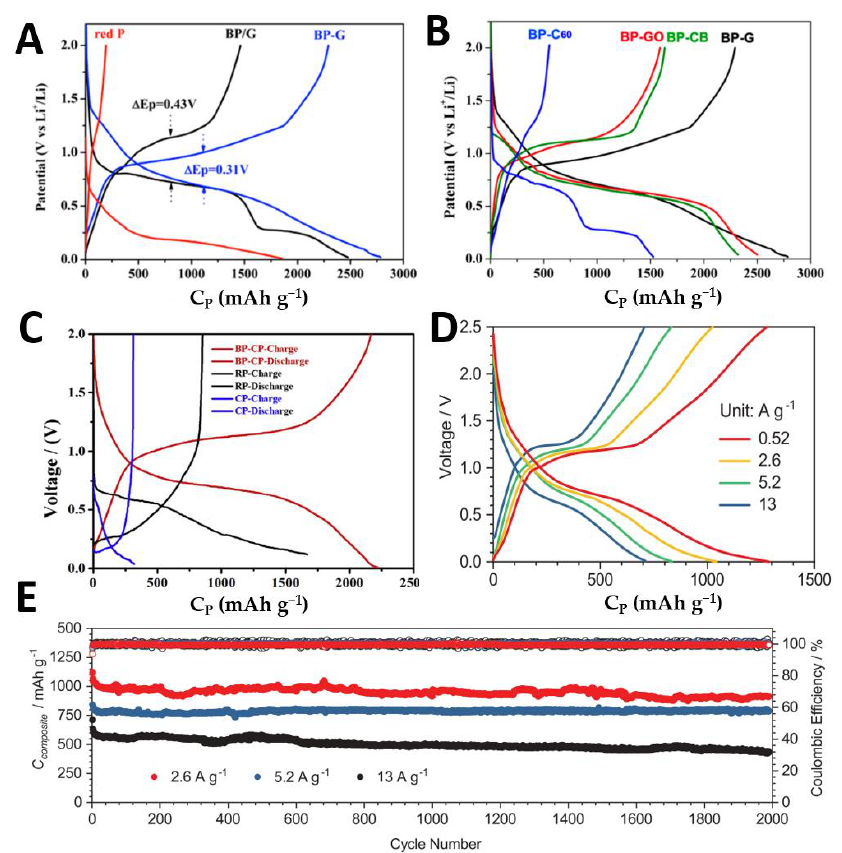
Figure 8. ( A ) First charge–discharge curves of Red P, BP/G, and BP-G at 0.01–2.0 V current density. ( B ) First charge–discharge curves of BP-C60, BP-GO, BP-CB, and BP-G at 0.01–2.0 V current density. Reproduced with permission [123]. Copyright 2014, ACS Publications. ( C ) The charge–discharge profiles of the initial cycle in the voltage range of 0–2 V. Reproduced with permission [124]. Copyright 2018, Elsevier. ( D ) Constant current charge and discharge and charge distribution under different current densities. ( E ) Cyclic performance of BP-G /PANI at current densities of 2.6, 5.2, and 13 A g − 1 . Reproduced with permission [125]. Copyright 2020, Springer Nature Limited.